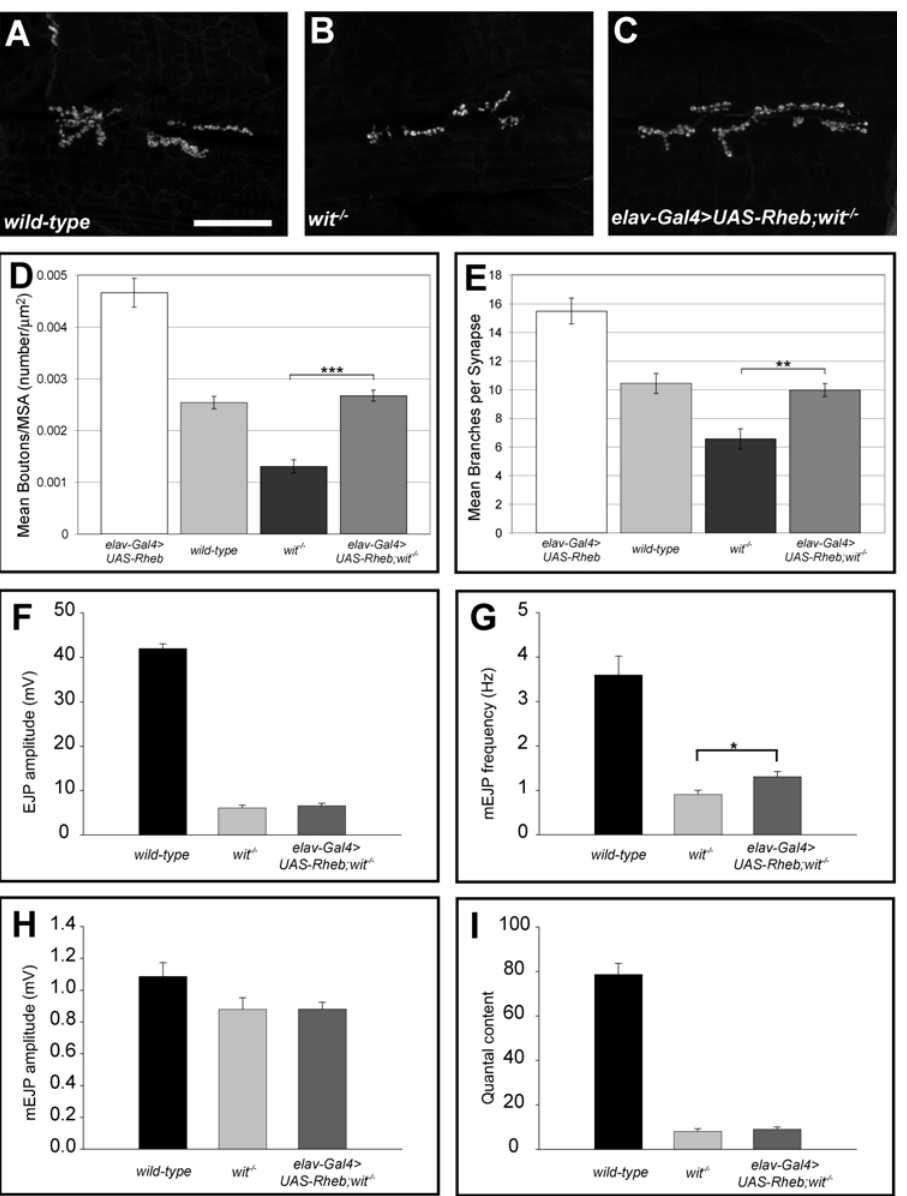
Figure 4. Rheb-mediated synapse expansion and physiological function is BMP-signaling dependent. Anti-CSP staining of synaptic boutons (panels A–C) shows the effects of wit on synapse growth (B), and the effects of neuron-directed expression of Rheb on wit mutant NMJs (C) compared to wild-type (A). Synapse size, measured by either the number of boutons/muscle area (D) or the number of motoneuron branches (E), is dramatically reduced in wit mutants (n=20) compared to wild-type (n=12), and is partially rescued by neuron-directed expression of Rheb ( elav-Gal4 . UAS-Rheb , n=24). Reductions in EJP amplitudes (F), mini-EJP amplitudes (H), and quantal content (I) mediated by loss of wit (n=8) are not rescued by neuron- directed expression of Rheb (n=16) (n=10 for wild-type) . The decrease in mini-EJP frequency of wit mutants, a measure of spontaneous vesicle release, is rescued to a significant degree by expression of Rheb in the motoneuron (G). The scale bar represents 50 microns.